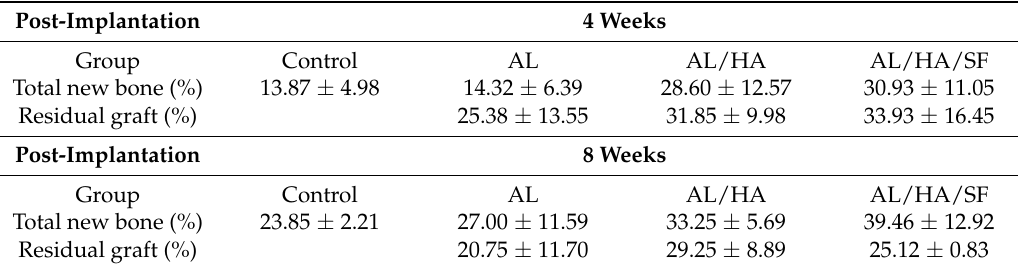
Table 1. Histomorphometric